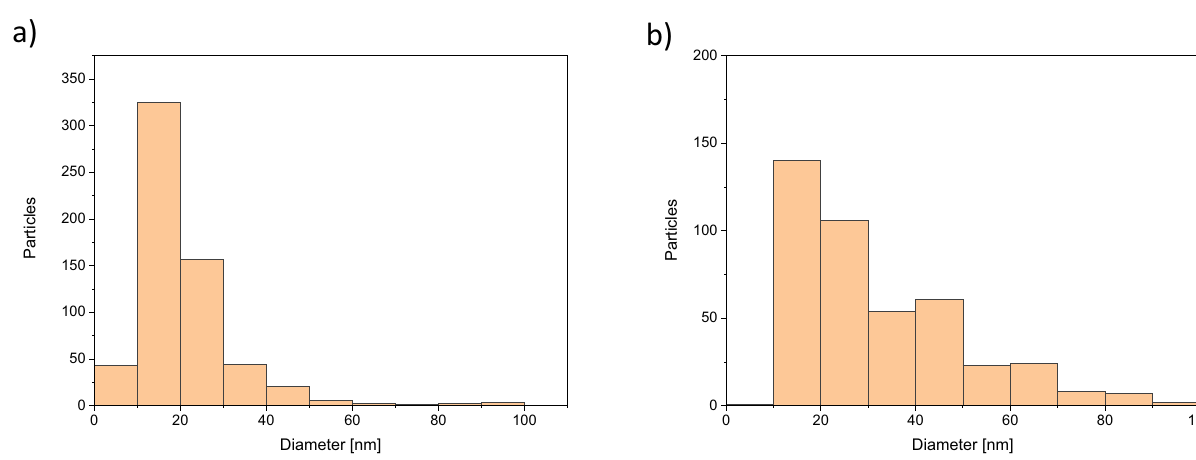
Figure 3: Quantitative analysis of the di ff erent particle sizes investigated during several TEM measurements for ( a ) Ag nanoparticles and ( b ) SiO 2 nanoparticles.